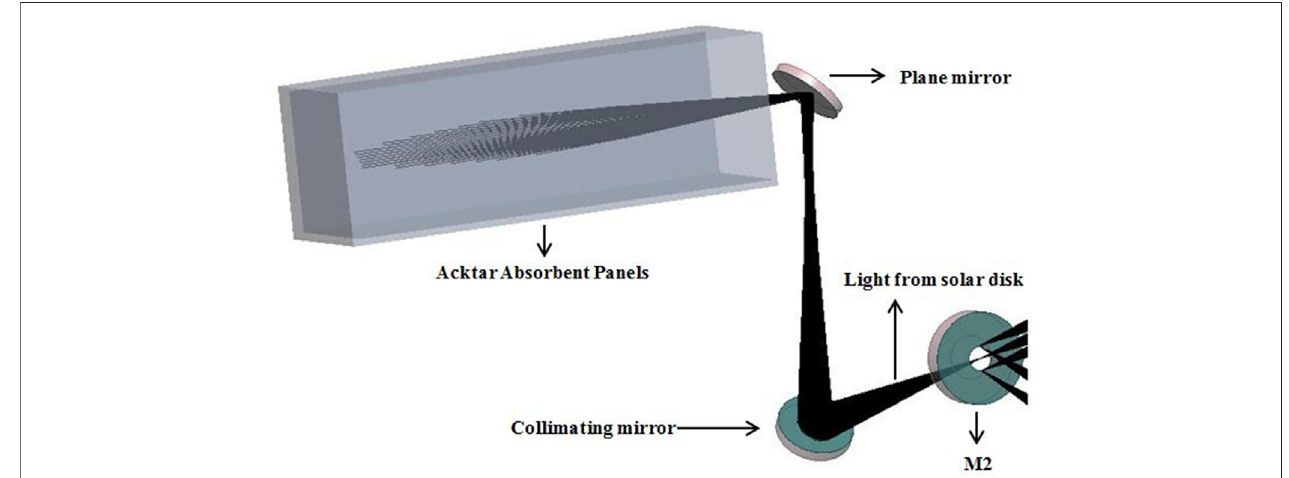
FIGURE 3 | Ray-tracing diagram of direct stray-light from the solar disk.